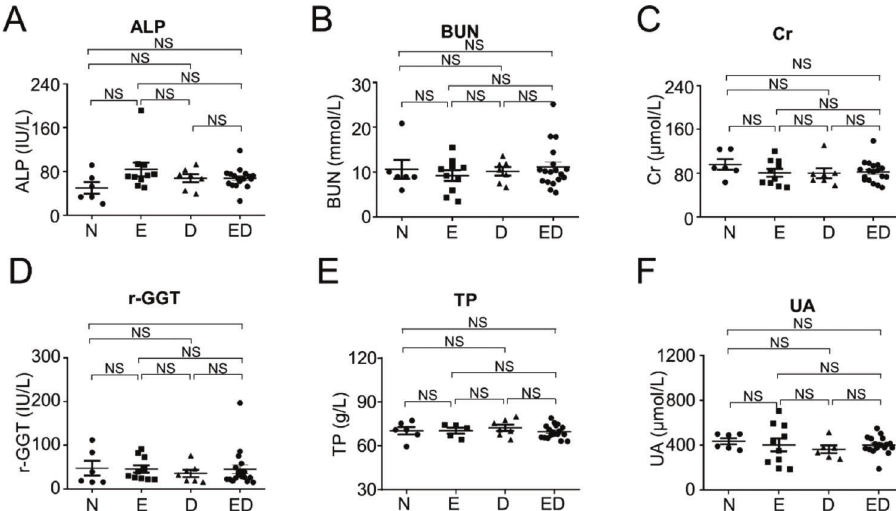
Figure S1 - Clinicopathological parameters involved in E, D ED, and healthy donor (N) groups. A-F ED-associated clinical parameters in E, D, ED, and N groups, including ALP ( A ), BUN ( B ), Cr ( C ), r-GGT ( D ), TP ( E ), and UA ( F ). All data are shown as the mean ± SEM. NS, not